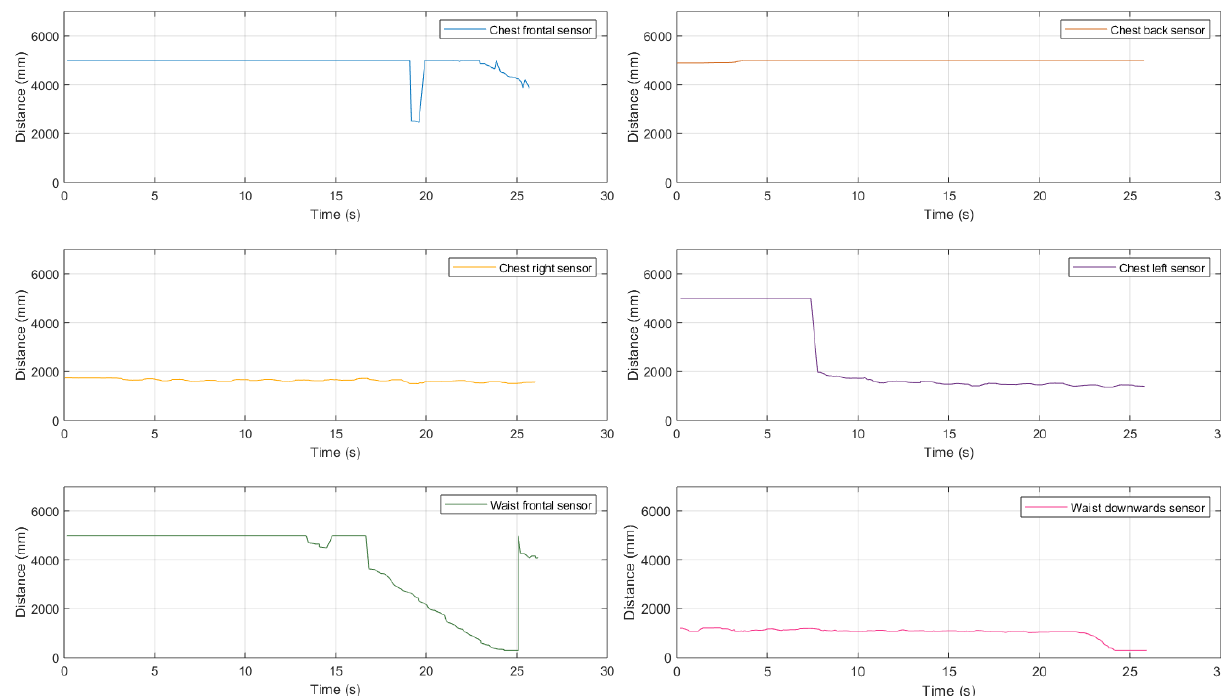
Figure 20. Experimental distance estimates obtained with the configuration shown in Figure 17, in the presence of a 38 × 88 cm large-size obstacle along the path.